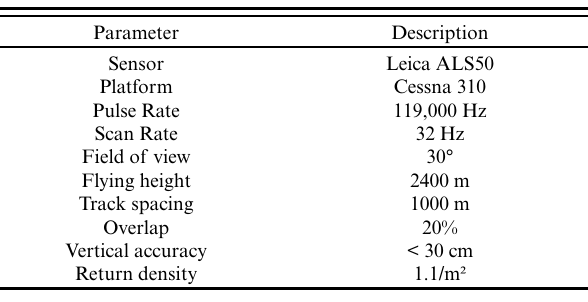
Table 1 . Light Detection and Ranging (LiDAR) acquisition specifications for the Hearst Forest.